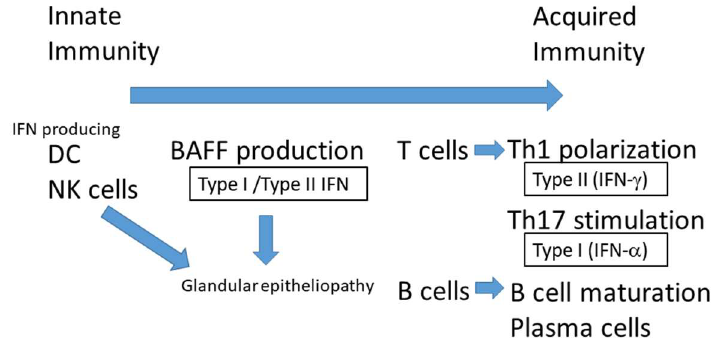
Figure 1. IFNs are involved in both the early stage of innate immunity, in which the type I IFN is elevated in glandular tissue and sera, and the later phase of disease progression, in which type I and type II IFN produce T cells and B cells, stimulated by B-cell-activating factor (BAFF) in SS. Natural killer (NK) cells can activate immature dendritic cells (DCs) through the secretion of IFN- γ . Increasing levels of type II IFNs, such as IFN- γ , are observed in primary SS [2]. The polarization of IFN- γ -secreting Th1 cells is implicated in SS pathogenesis. DC; dendritic cells, NK cells: natural killer cells, IFN; interferon, BAFF: B-cell-activating factor.